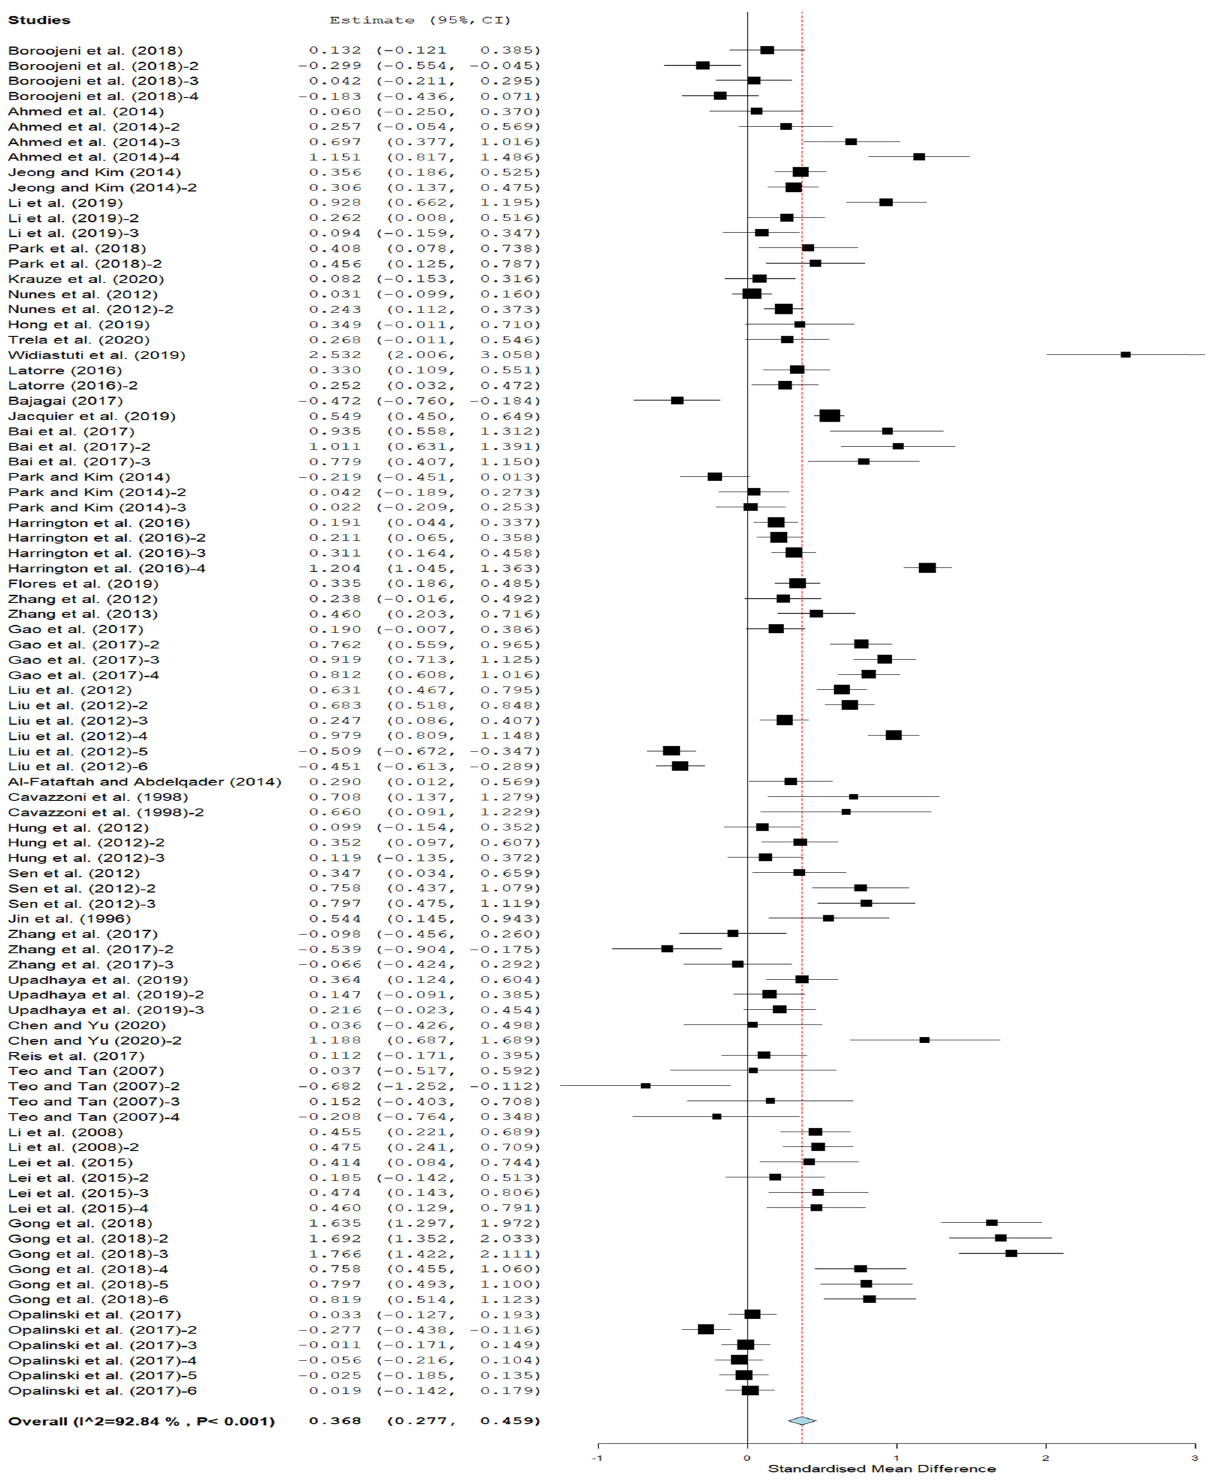
Figure 5: E ff ect of Bacillus supplementation on ADG in broiler chickens. Pooled estimation ( SMD ) = 0 ( thick line ) suggests no e ff ect, SMD > 0 suggests an increase in variables of interest over the controls and SMD < 0 denotes a decline in variables of interest over the controls. The dotted line with a diamond denotes the cumulative e ff ect size across all studies used for the meta -